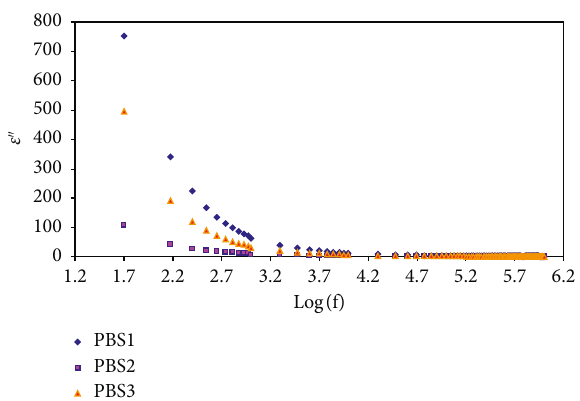
Figure 5: Dielectric loss versus frequency at ambient temperature for CS:POZ blend